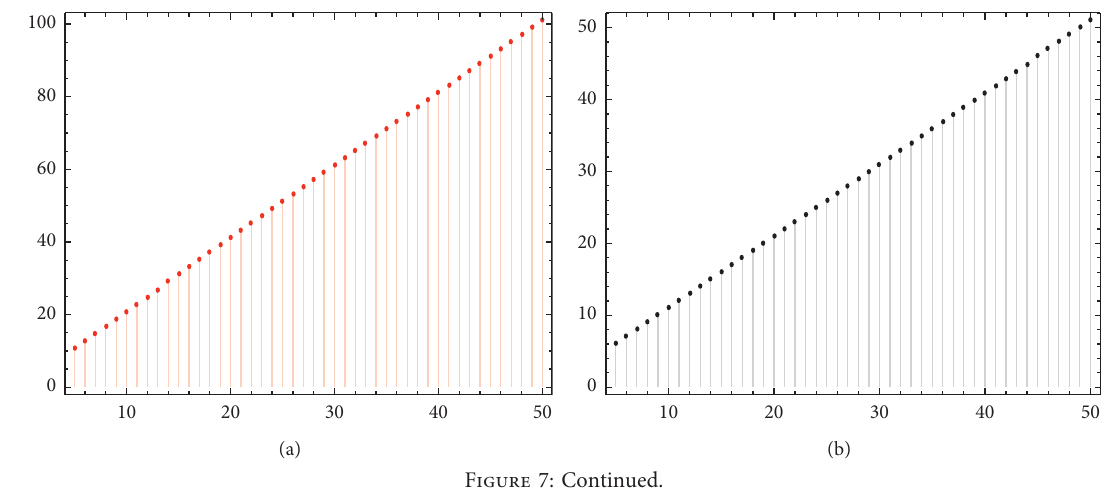
, i � 1 , 2 , 5 , 6 , 11 , 14, and their n